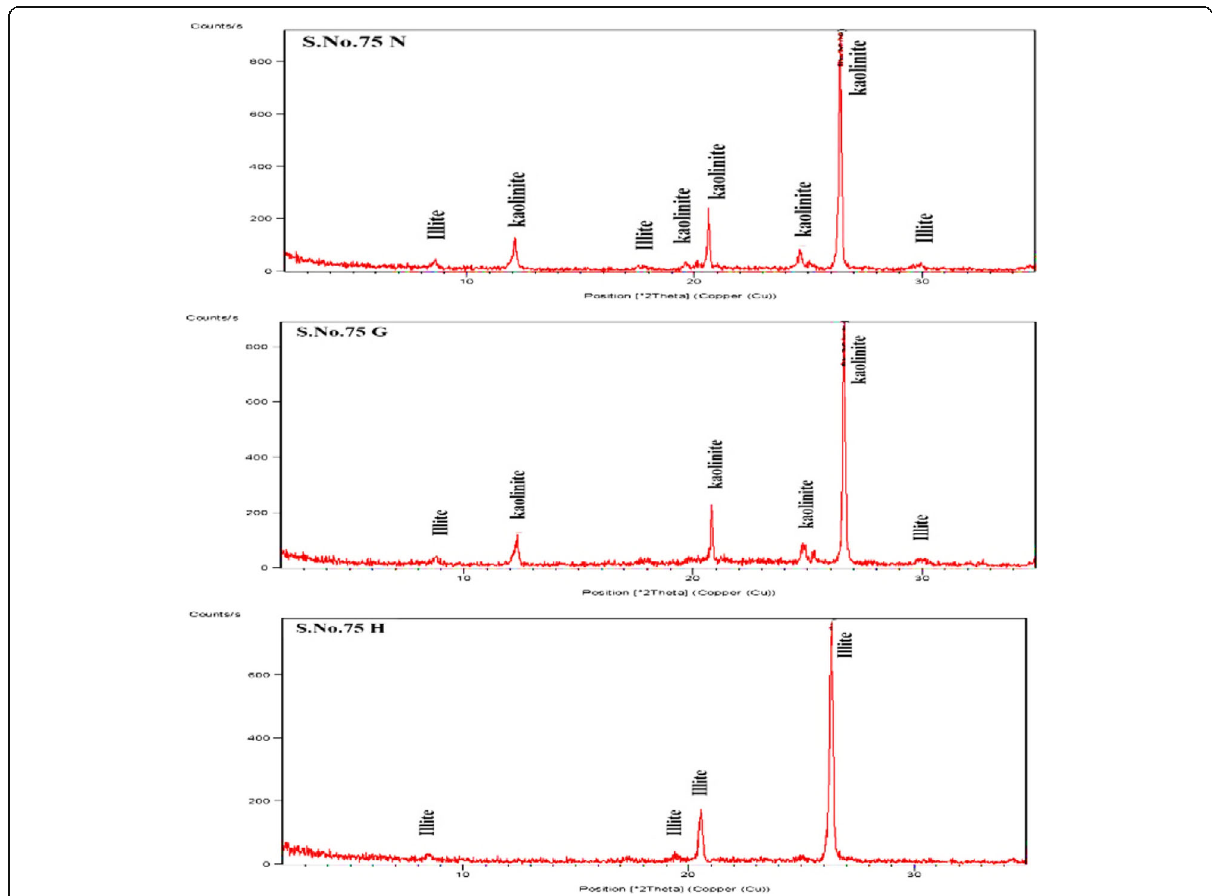
Fig. 5 X-ray diffraction pattern of oriented clay samples of Paleozoic mudrocks, S. No. 75